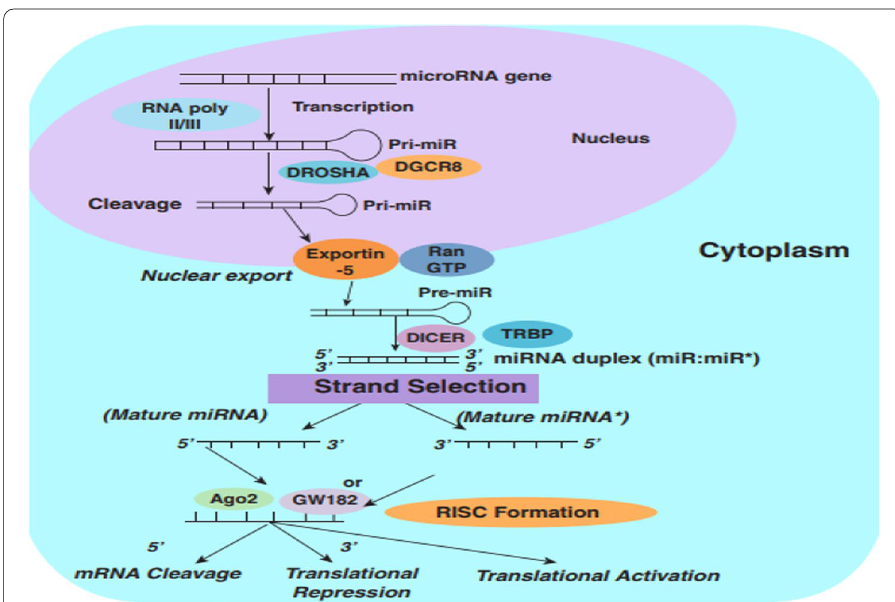
Fig. 1 MicroRNA biogenesis. miRNAs are produced from miRNA genes, which are transcribed via RNA polymerase II/III to form primary miRNA termed pri‑miRNA. Thereafter, pri‑miRNA is cleaved by Drosha and DGCR8, and forms precursor microRNA (pre‑miRNA), which is exported to the cytoplasm via Ran‑GTP and exportin‑5 to undergo maturation. miRNA duplex composed of mature miRNA is generated from cleaving the pre‑miRNA, which is processed by Dicer and transactivation response element RNA‑binding protein (TRBP). The single strand of mature miRNA, containing Ago‑2 and GW182 proteins, binds to the complex, namely RISC. This complex modulates miRNA target gene expression by target miRNA cleavage and translation